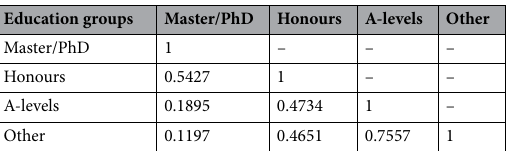
Table 6. P-values based on paired Wilcoxon tests for usability scores in four education